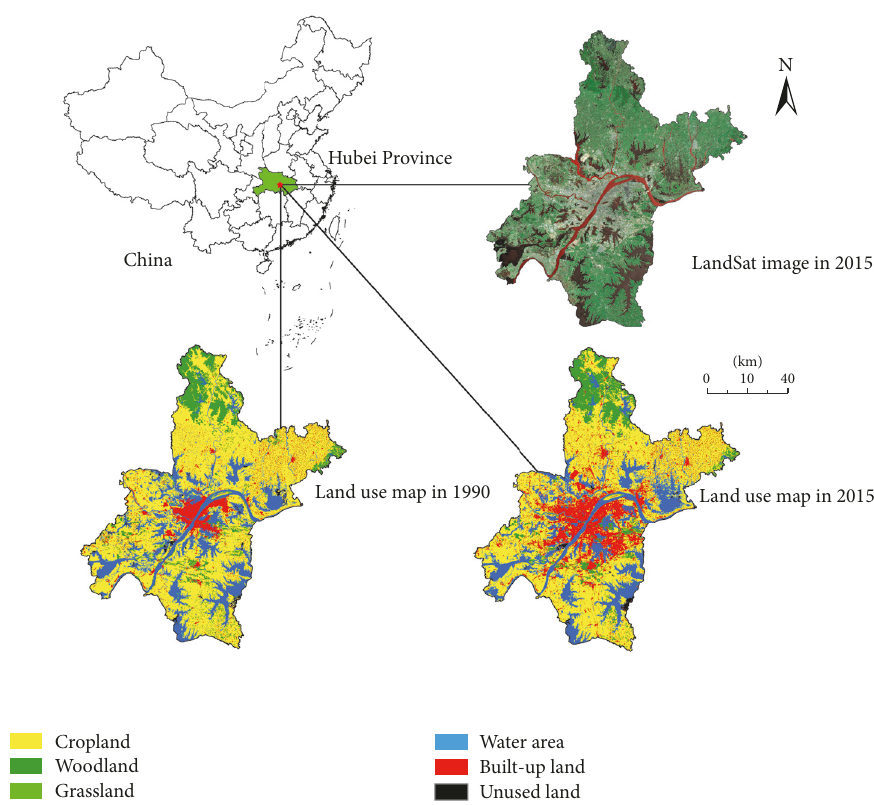
Figure 2: Study area: geographic location, a Landsat image, and land use changes during 1990–2015 of Wuhan